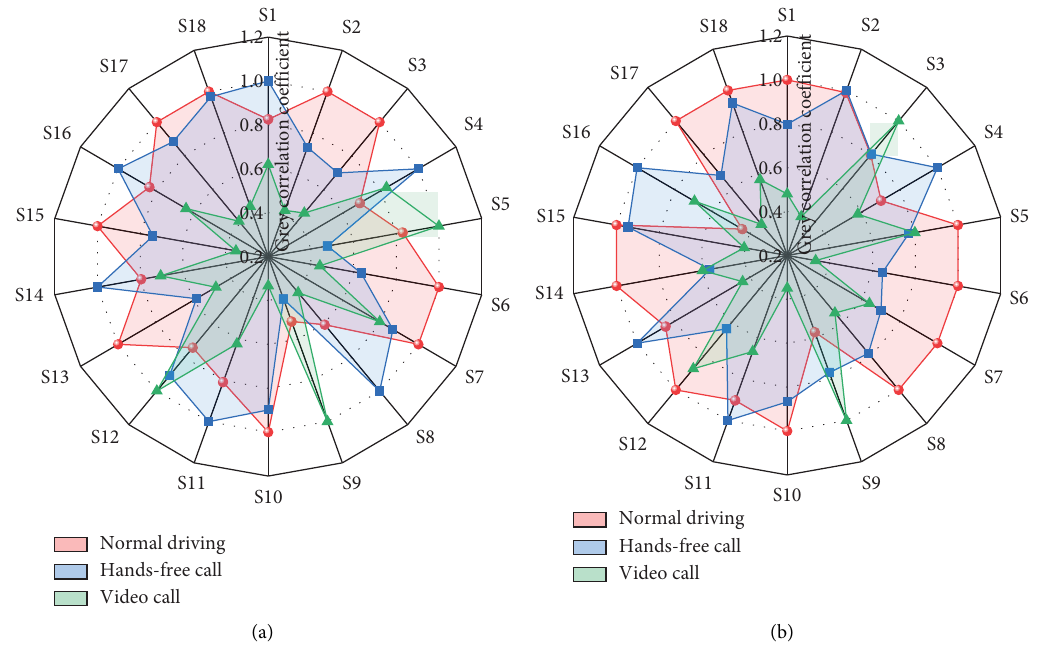
Figure 12: Te grey correlation coefcient of diferent driving states in FFS and CFS. (a) FFS. (b) CFS. Table 14: Evaluation results of grey correlation analysis